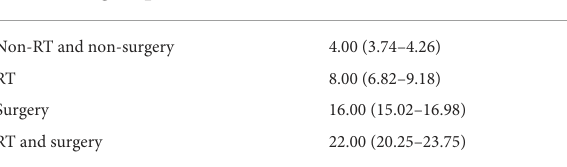
TABLE 4 Median overall survival time *